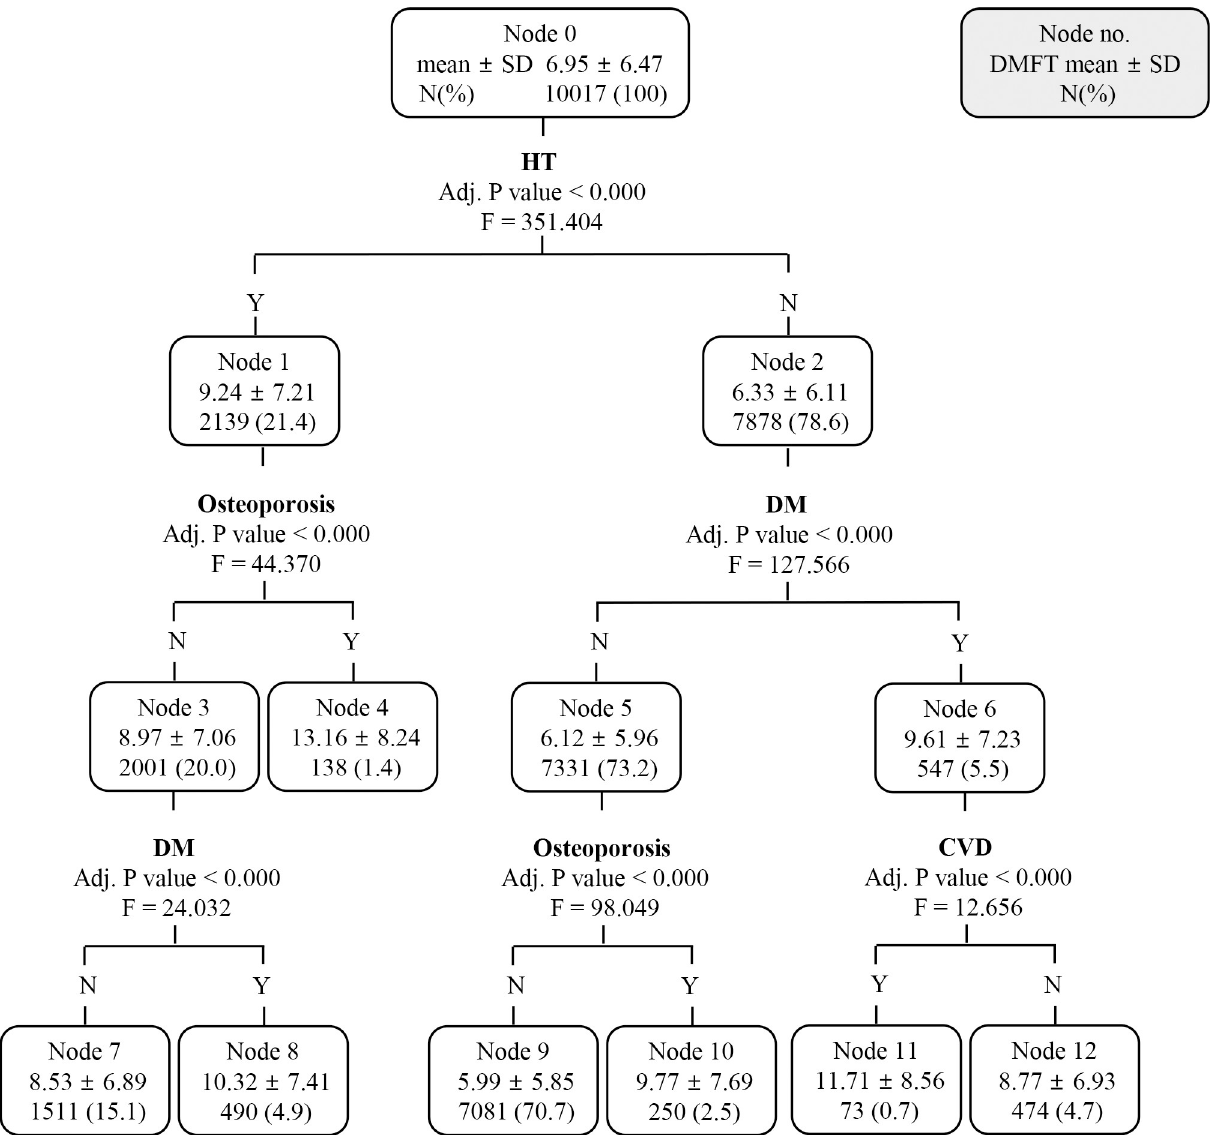
Fig 2. A chi-square automatic interaction detection classification tree analysis to identify the predictors related to the DMFT of all subjects; excluding age. Data were presented as mean ± standard deviation. HT, hypertension; DM, diabetes mellitus; CVD, cardiovascular disease. https://doi.org/10.1371/journal.pone.0257079.g002 root node to the leaf node, with the average DMFT score varying from 5.99 ± 5.85 to 13.16 ± 8.24 (Fig 2). In the newly created decision tree, the first decision split was based on HT, and the patients with HT had a DMFT score of 9.24 ± 7.21, which was about three more compared to that of patients without HT. The patients in node 1 (with HT) were split accord- ing to osteoporosis at the second-level split, and the DMFT score was higher in osteoporosis patients. At the third-level split, patients with HT and osteoporosis were no longer split, but patients with HT without osteoporosis were re-split according to DM status. The individual in node 8 (with HT, without osteoporosis, and with DM) had a DMFT score of 10.32 ± 7.41, which was higher than that of node 7 (with HT, without osteoporosis, and without DM). HT- free patients on the right side of the decision tree were split by DM status at the second level.